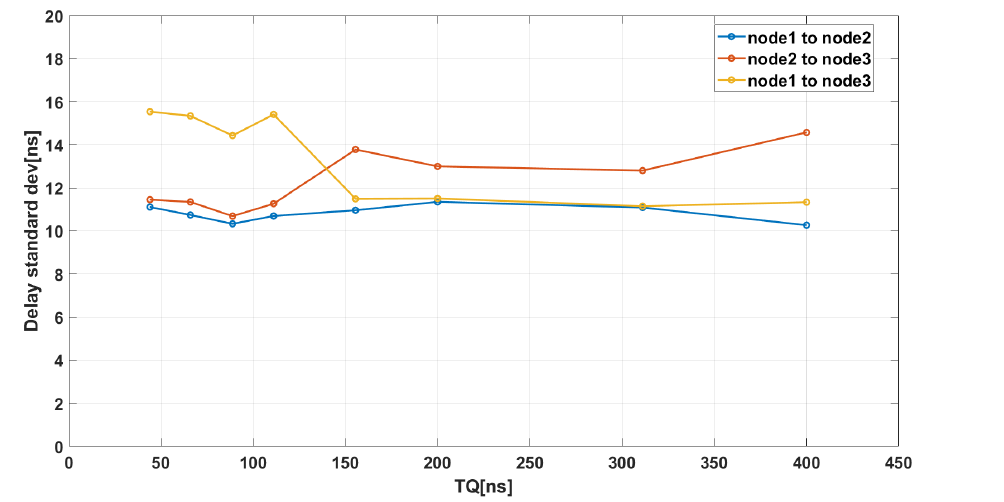
Figure 7. GPIO peripheral synchronization: standard deviations of delays as a function of the time